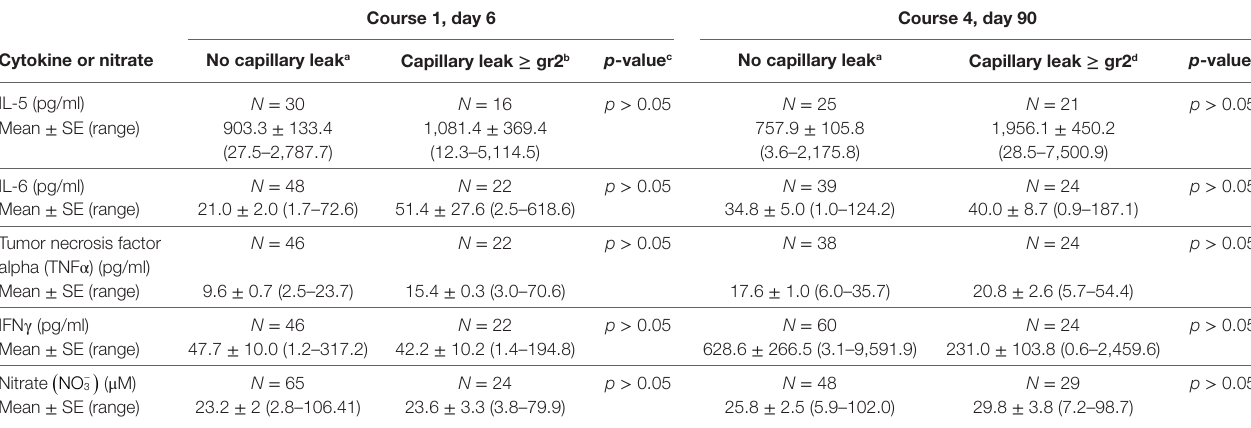
TaBlE 8 | Relationship of cytokine and nitrate levels with capillary leak in ANBL0931